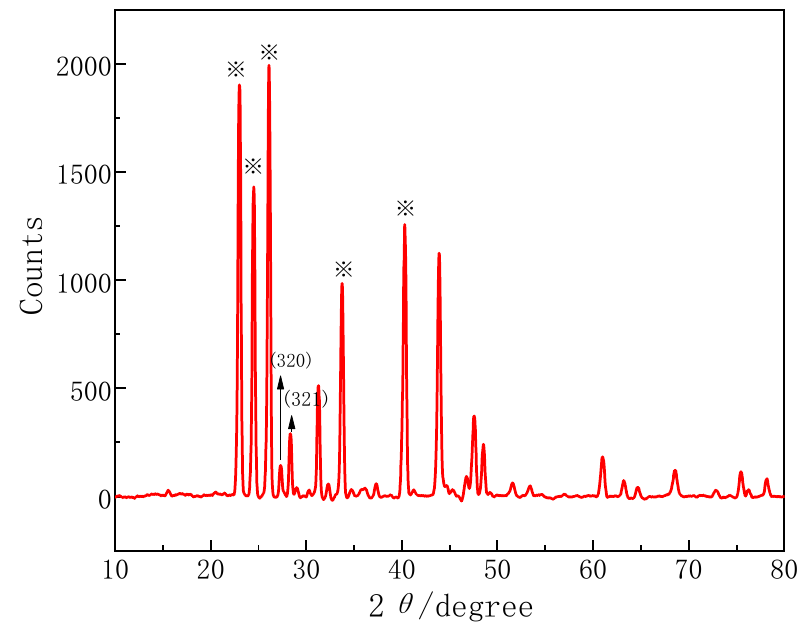
Figure 4. XRD patterns of CO 2 hydrate formed by 3.5 wt.% NaCl solution. Note: ※ is the diffraction peak of ice.